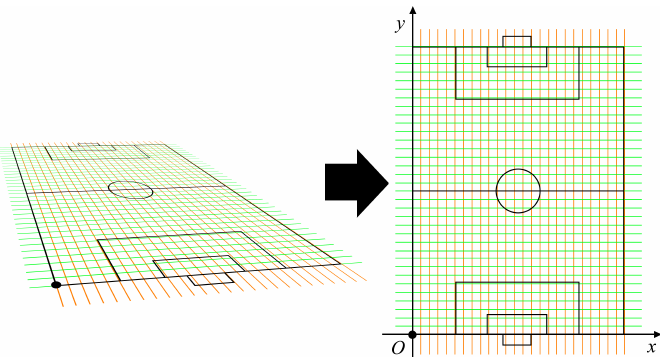
Figure 4. Overview of the coordinate transform. The coordinate system to the right is orthogonal, for which the black dot is set as the origin. The short side of the soccer field is set as the x-axis. The long side is set as the y-axis. Because coordinates are associated from both left and right spaces, if we know the coordinates of the player in the left space, the coordinates in the right space can be easily obtained.